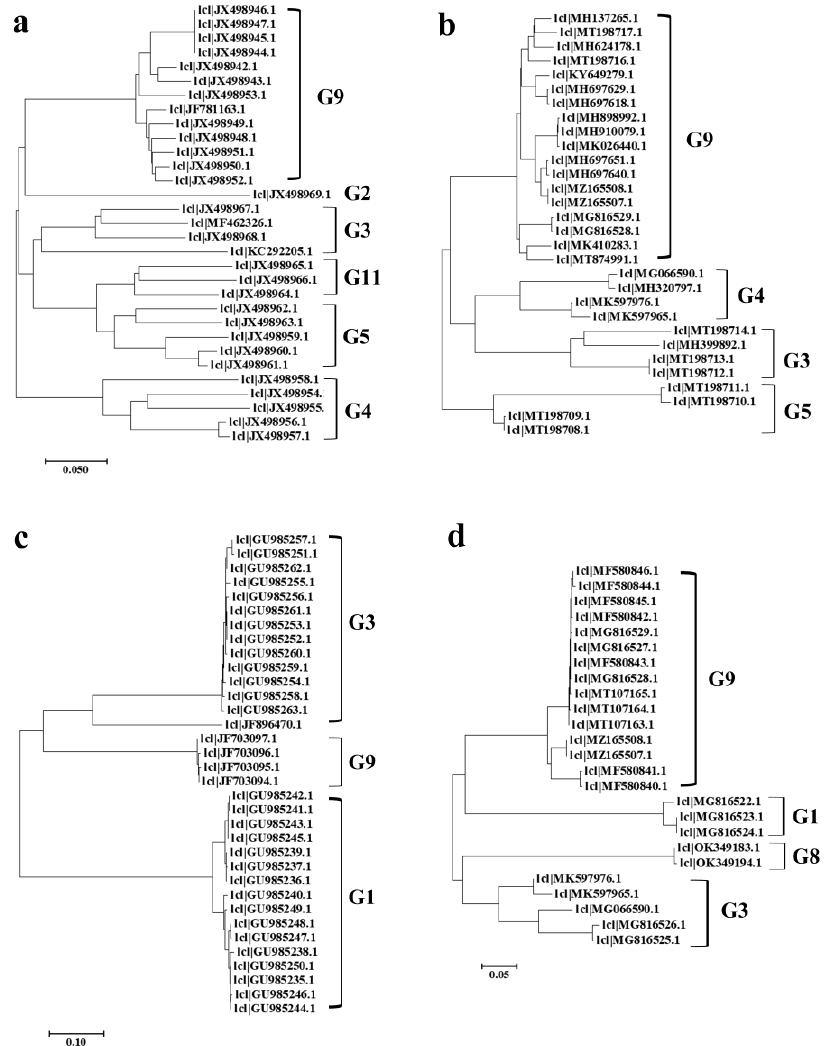
Figure 7. Phylogenetic analysis based on the VP7 genes of the PoRVA strains and human ro- tavirus strains. ( a , b ) Phylogenetic analysis based on the VP7 genes of the PoRVA strains before ( a ) and after ( b ) 2018. ( c , d ) Phylogenetic analysis based on VP7 genes of human rotaviruses strains before ( c ) and after ( d ) 2018.